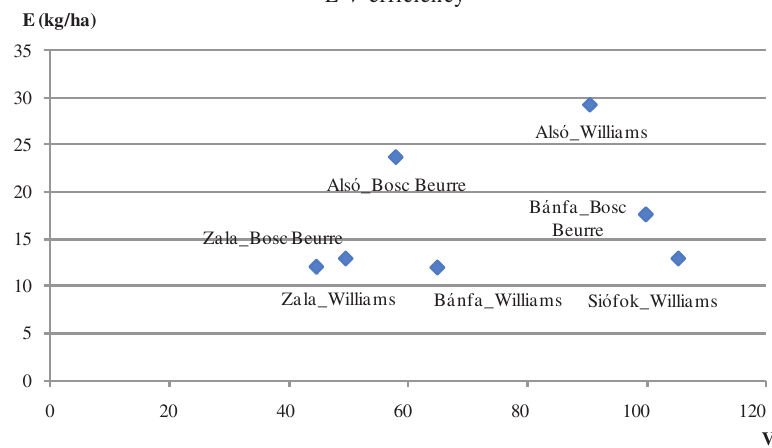
Figure3. E-V efficiency for four different plantations and two pear varieties (‘Williams’and ‘Bosc Beurre’)